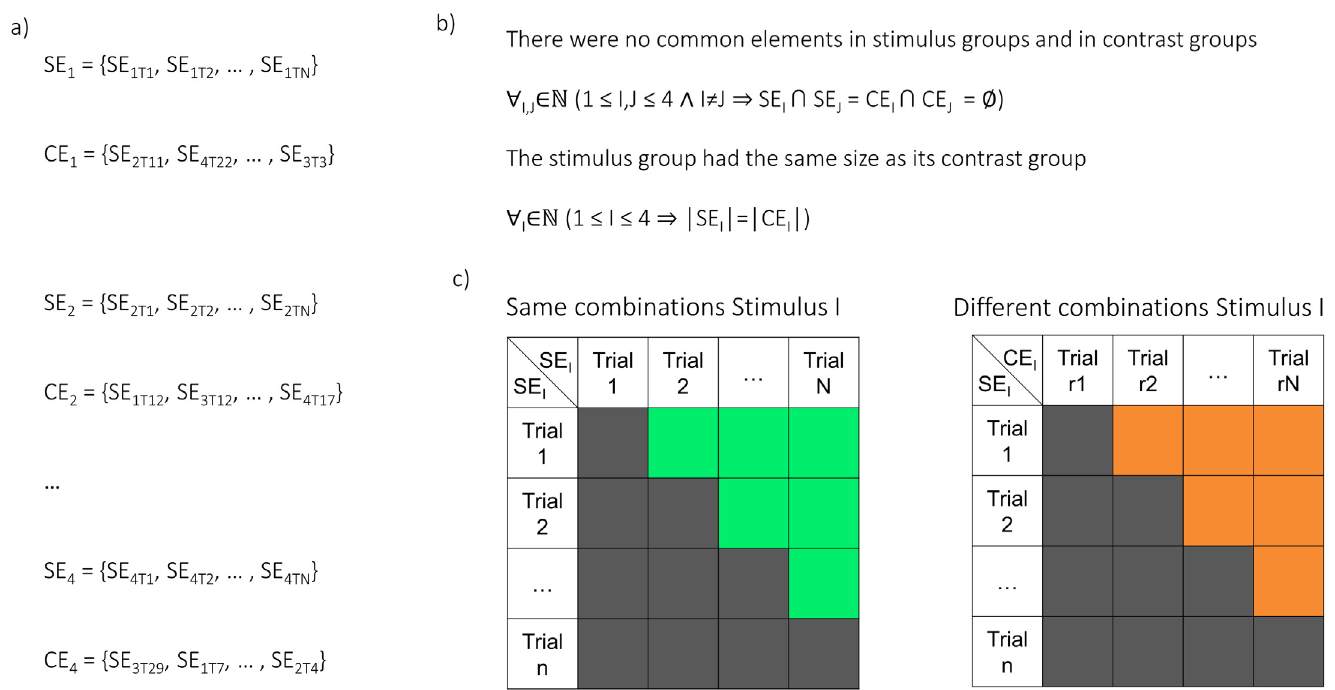
Fig 8. Trial combinations between same and different content during encoding. Each cell in the upper right regions (green and orange) indicates a pair of trials that are compared, i.e., cosine of angular distance. SEk,Tm denotes a trial, where k denotes one of the four videos (or sounds), and m a trial of that video (or sound). (a) Trials at encoding were divided into sets of the same stimulus content (SE1-4). A contrast set, namely, a set containing a random selection of trials of different content, was assigned to every stimulus set (CE1-4). (b) None of the same-content sets or the contrast sets shared any trial. The size of each stimulus set was the same as the size of its contrast set. To ensure this, some trials were discarded from analysis. (c) For N trials of content I (in the set SEI), the N * (N-1)/2 unique trial combinations were built. This corresponds to the above diagonal region of a combination matrix (green cells). From all the possible combinations of different content between a trial set (SEI) and its contrast set (CEI) only the combinations above the diagonal were selected (orange cells) for contrast. This is equivalent to exchanging one side of the combinatory pairs that were built within a stimulus set (i.e., left matrix), with trials from its contrast set (replacing all instances of one trial with instances of a trial from the contrast set). The same- content combinations and the different-content combinations of all four stimuli were then contrasted.